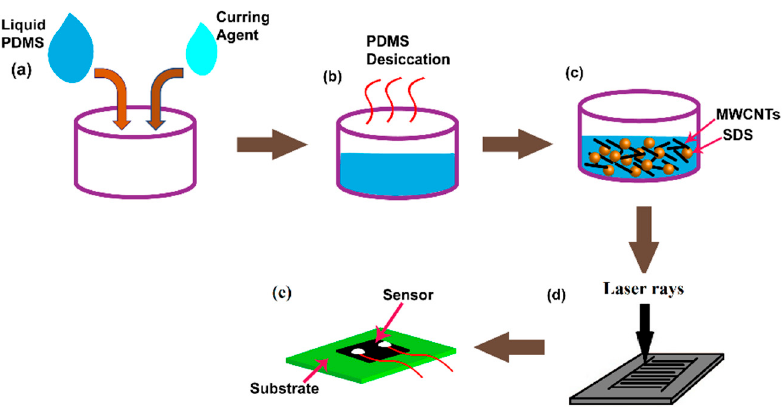
Figure 1. Schematic diagram of steps involved in the process of fabrication of MWCNTs/SDS/PDMS-based sensors.